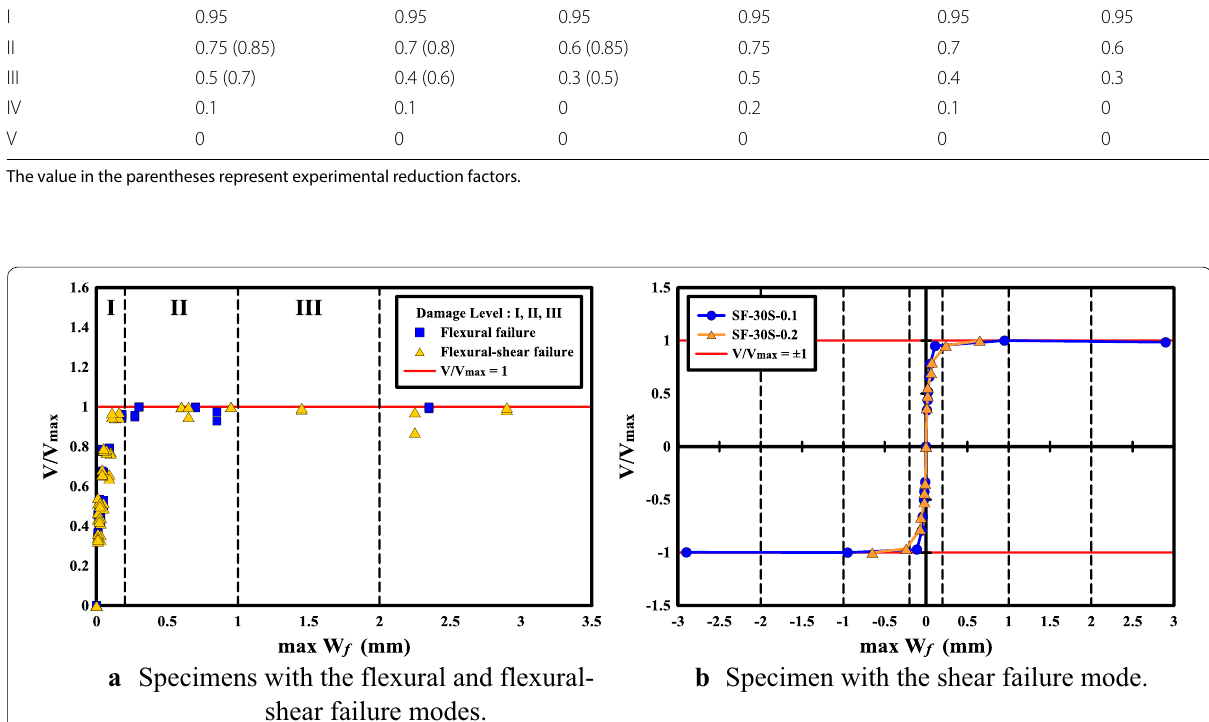
Fig. 15 Relationship between the reduction factor of strength and maximum residual flexural crack width.